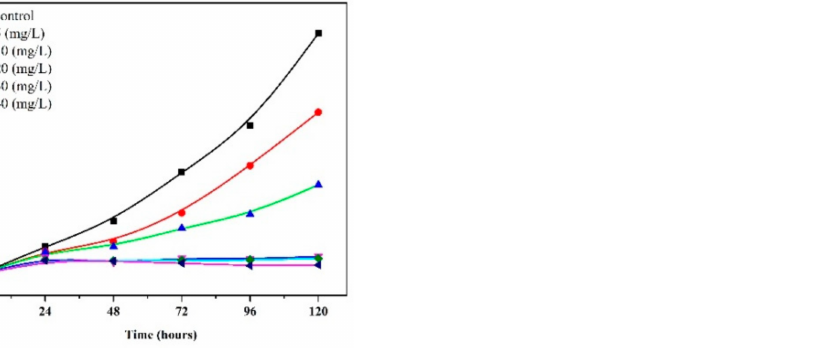
Figure 7. Time-dependent results of biovolume from a batch culture of Chlorella vulgaris under toxic IMD